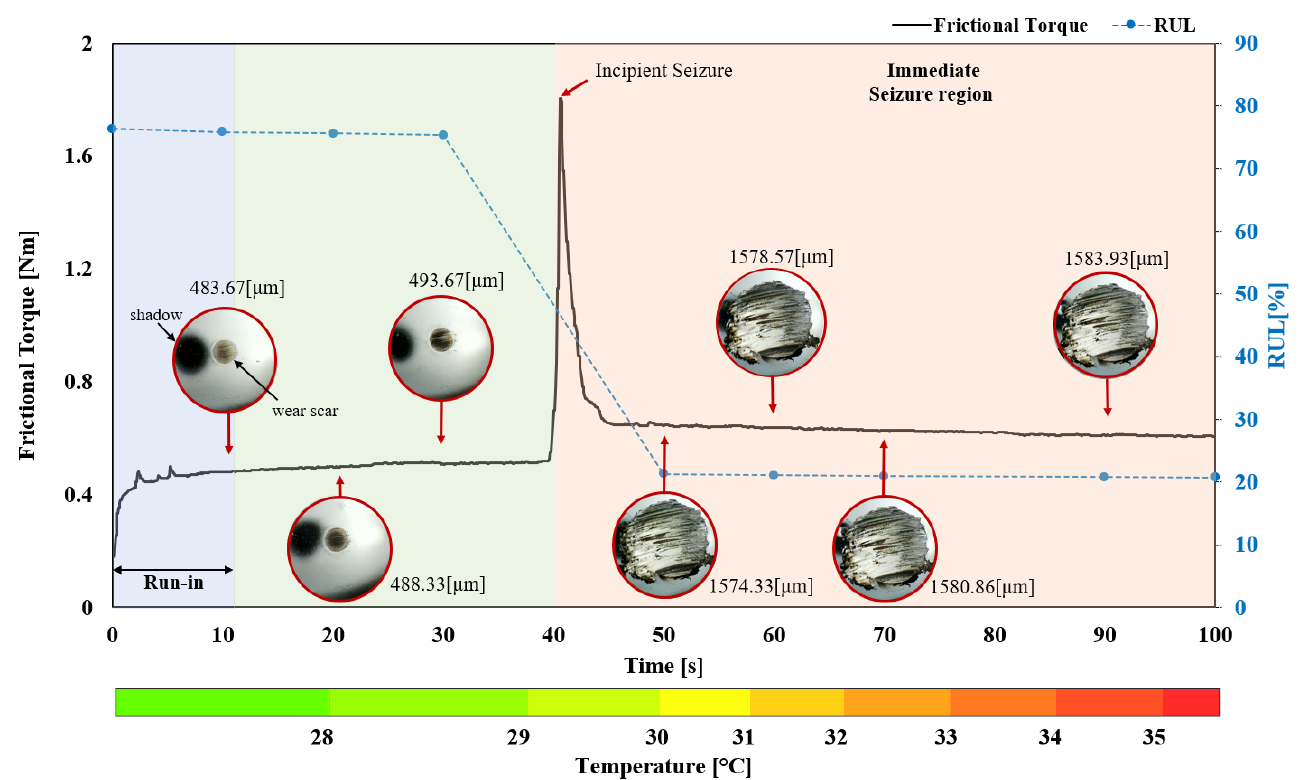
Figure 5. Wear scar, temperature, and RUL progression with time in a typical four-ball test. Note that in the first three images, the wear scar is in the center. The dark dot to the left of the wear scar is the shadow cast by the microscope